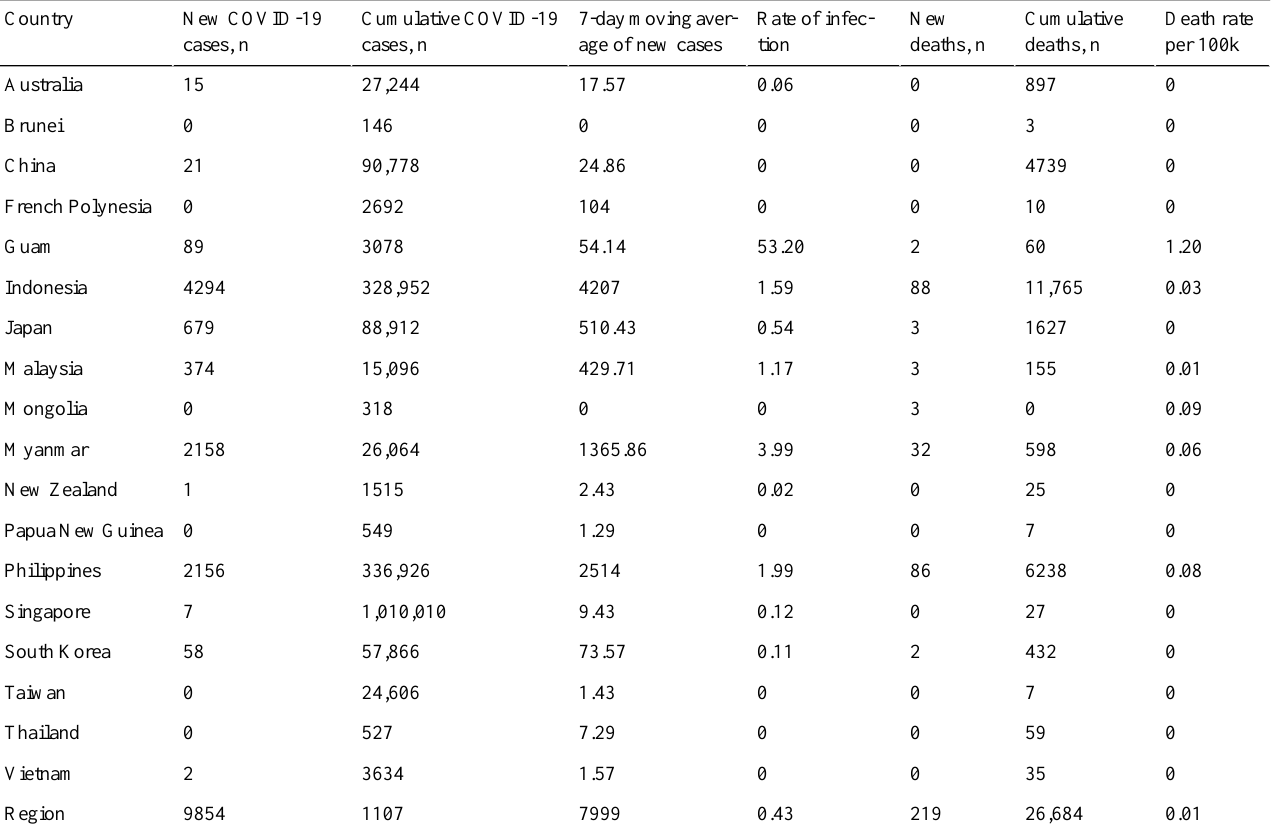
Table 2. Static surveillance metrics for the week of October 5-11, 2020.